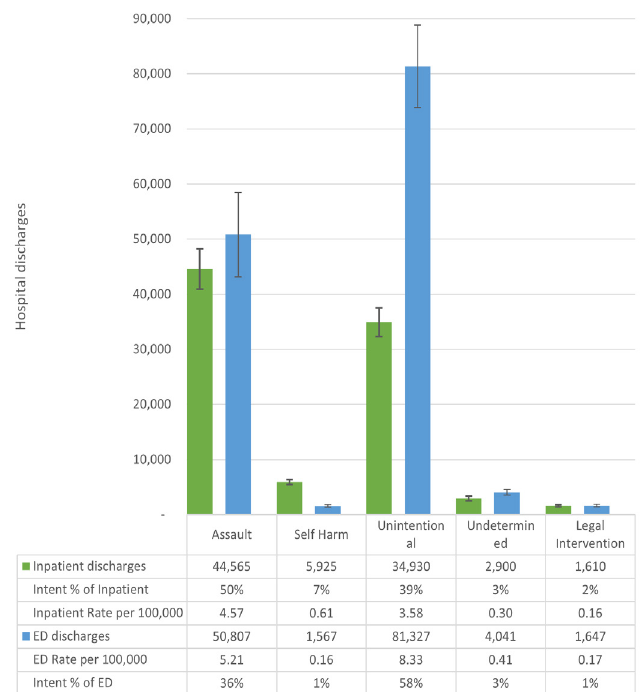
Figure 2. Number, rate per 100,000 population, and proportion of admitted and emergency department (ED) discharges for nonfatal firearm injuries in the United States, by injury intent, 2016-2018. Admitted firearm injury episodes estimated from the National Inpatient Sample (2016-18). Emergency department discharges estimated from the Nationwide Emergency Department Sample (2016-18). Lines represent 95% confidence intervals for weighted survey estimates. Proportions are for rows and may not total to 100% because of